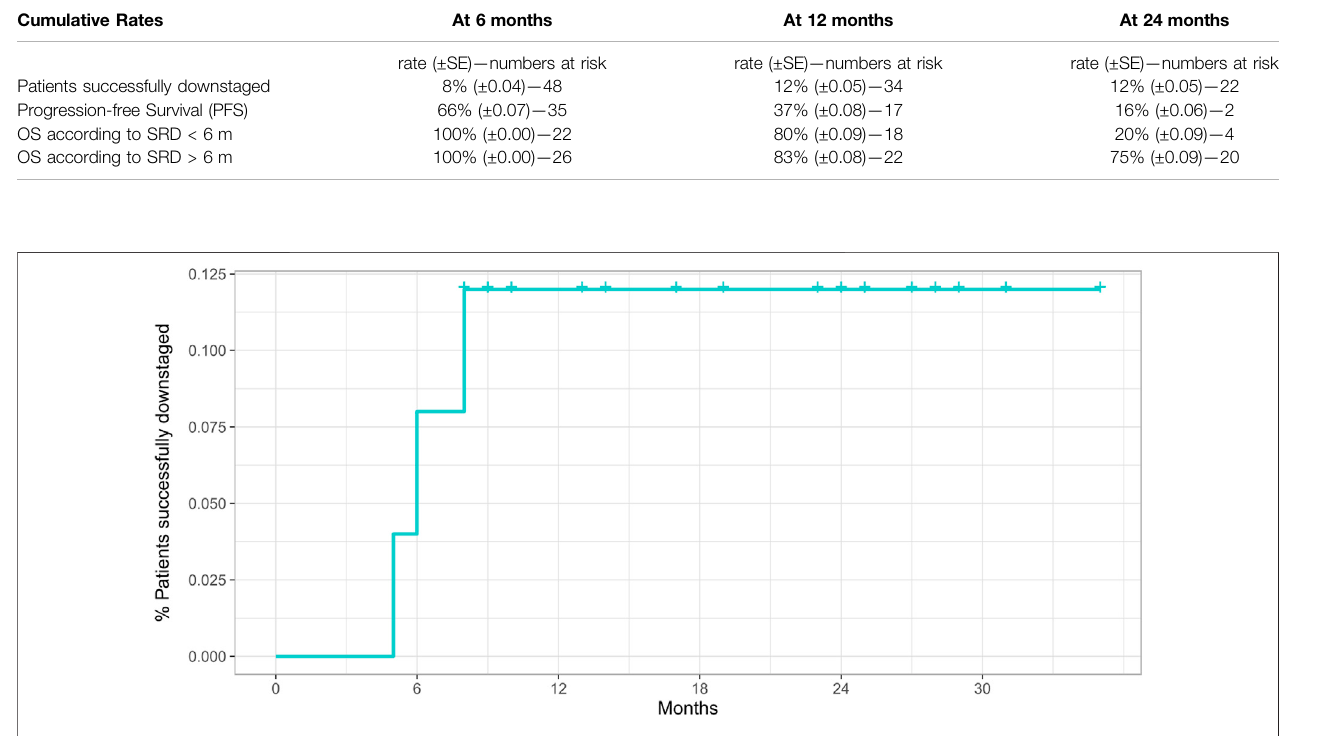
FIGURE 1 | Cumulative incidence of patients successfully